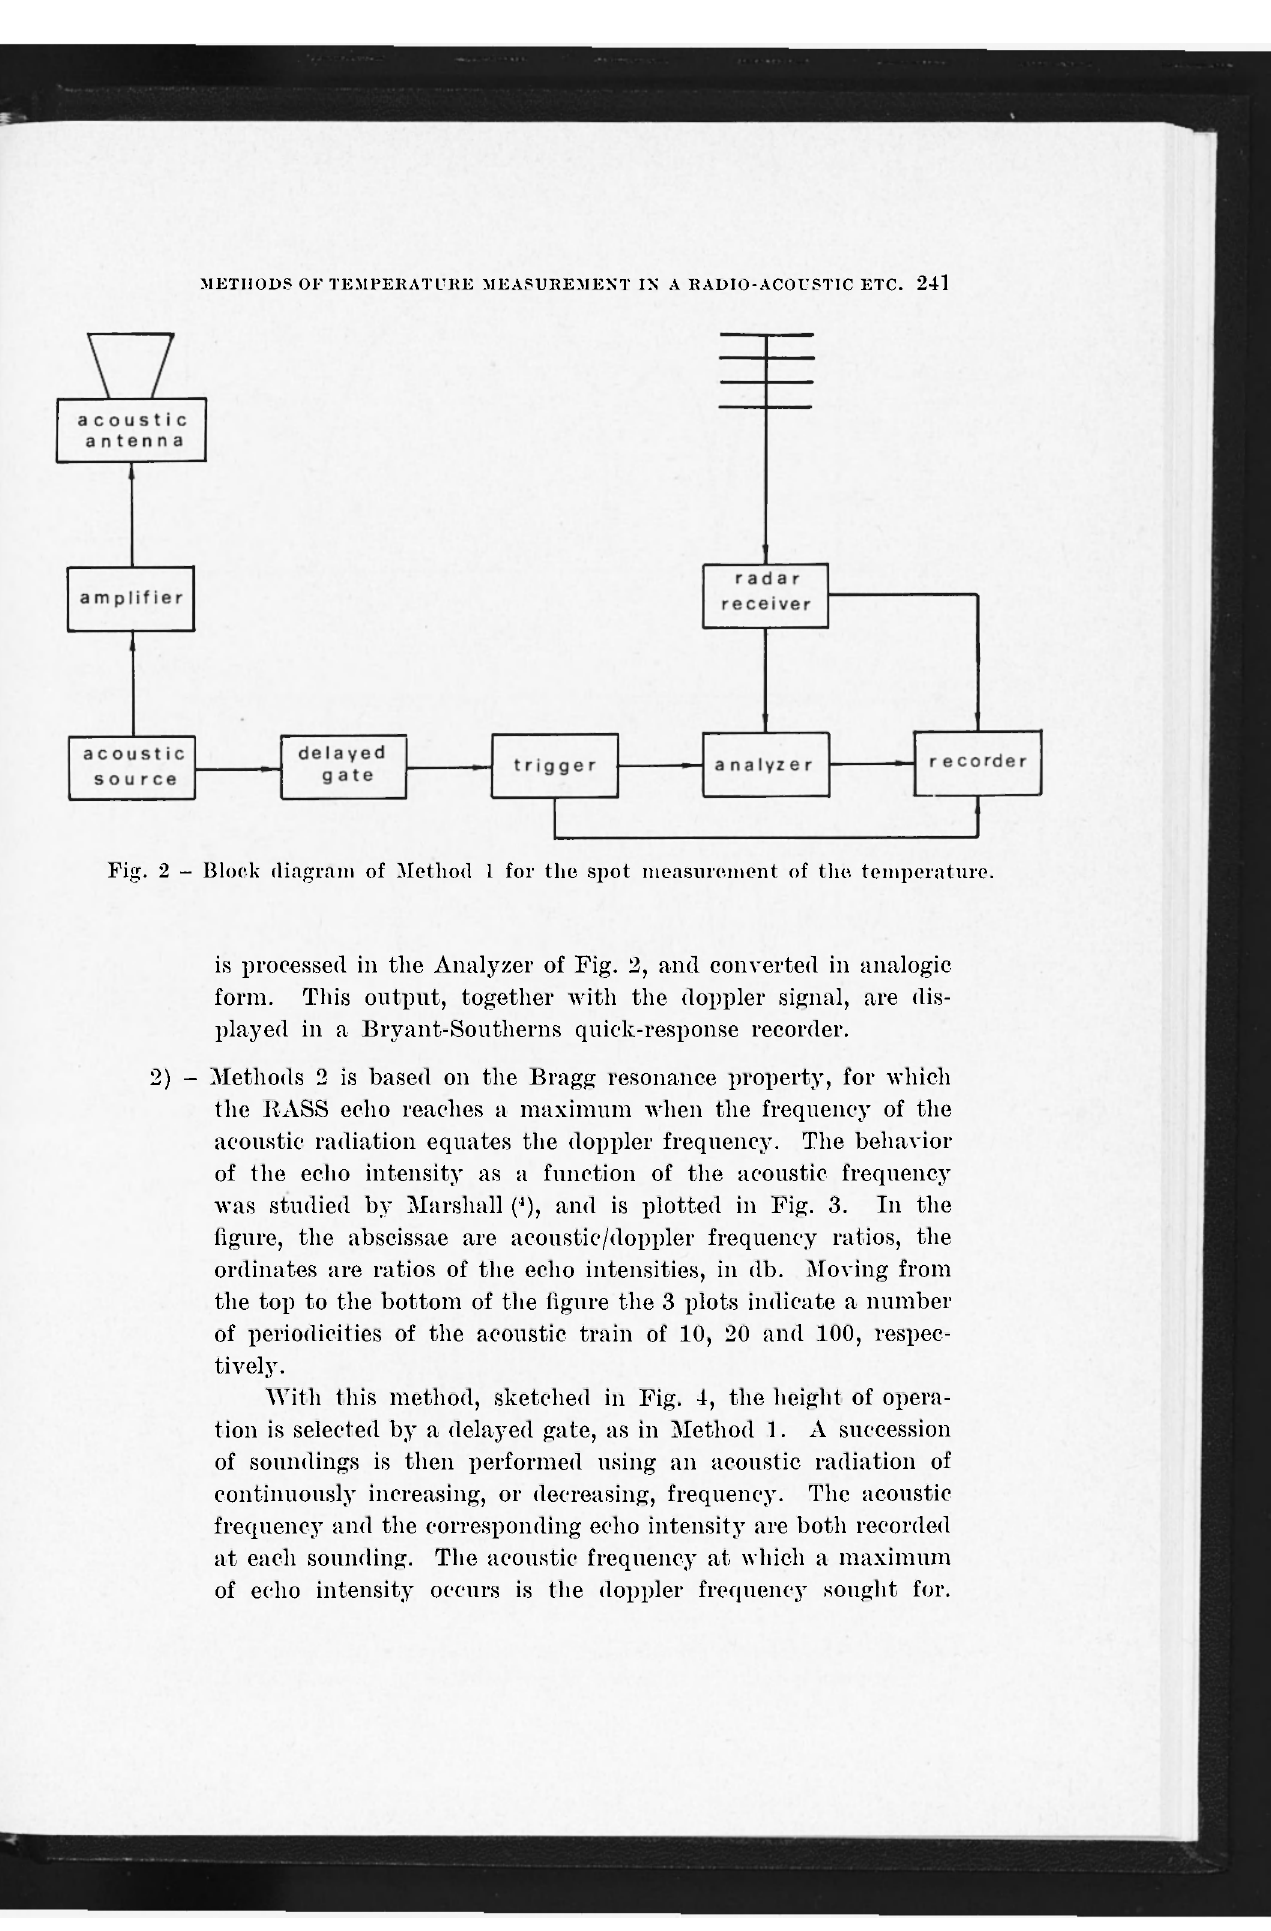
The behavior In the